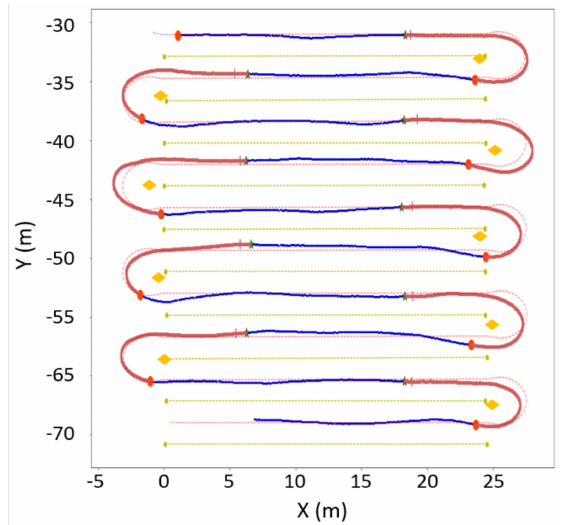
Figure 13. Robot path for the first 10 rows. The blue curve corresponds to the “IN_ROW_NAVIGATE” state. The red dots represent the points where the robot detected the row entry. The green stars corre- spond to the positions where the robot detected the row end and entered the “U_TURN_NAVIGATE” state. The yellow diamonds correspond to the detected row ends on the robot’s turning